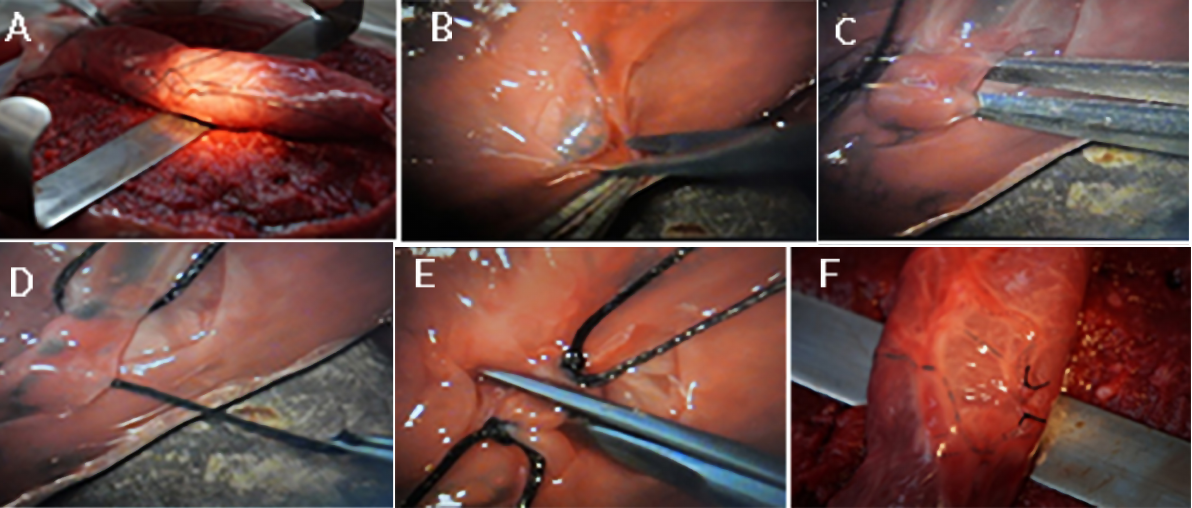
Figure 2 - Microsurgical handling of placenta vessels simulating the varicocele treatment. A) Simulated spermatic funiculus put under microscopic working area. B) Allantoic membrane dissection for access to the placenta vessels. C) Placenta vein dissection, after identify artery. D) Placenta vein knot tying. E) Placenta vein micro-scissors cutting. F – Final appearance of vein cutting in the simulated spermatic